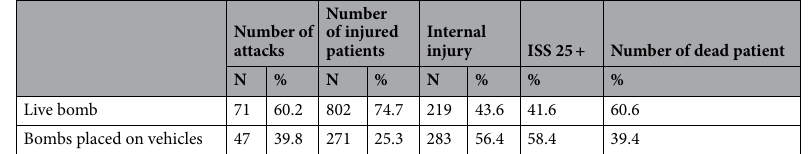
Table 3. Characteristics of explosion injuries according to 2 different subgroup mechanisms. ISS Injury severity score.